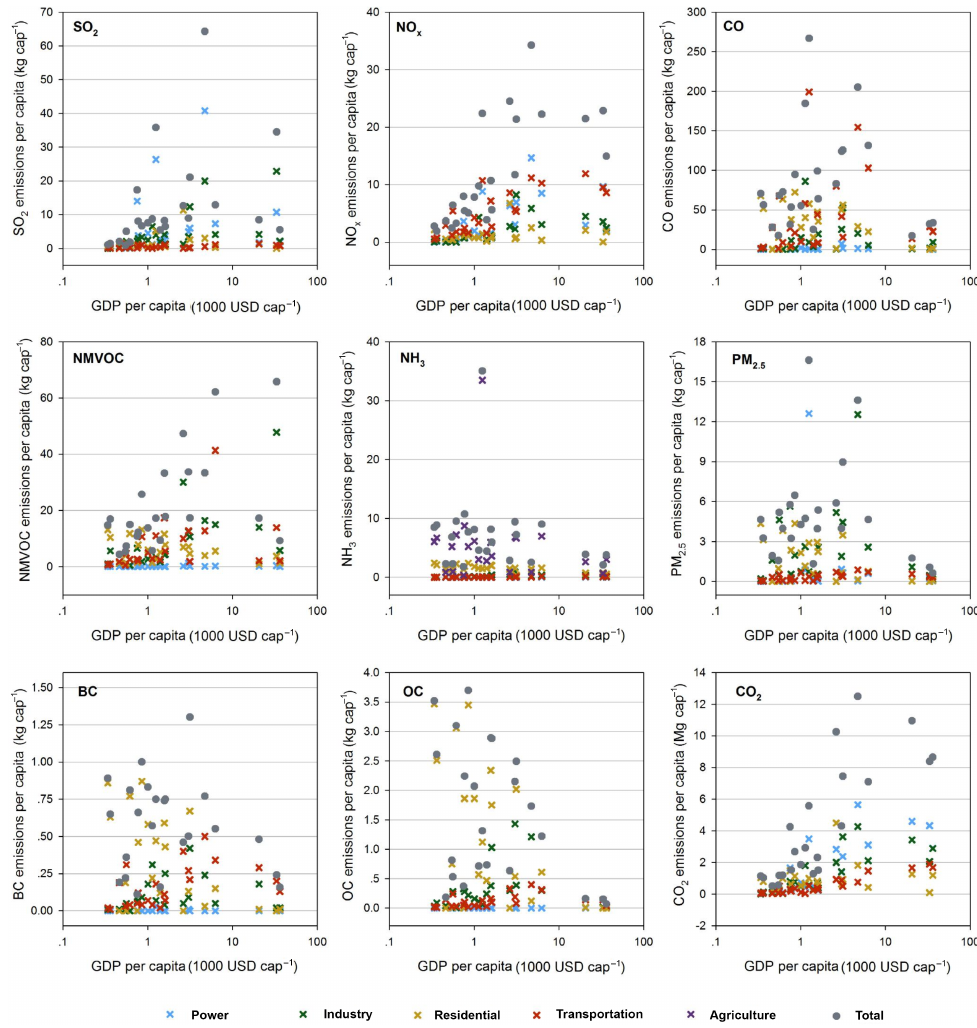
Figure 6. Per capita emissions by sector for 2010 in MIX, ranked by GDP per capita for each country.